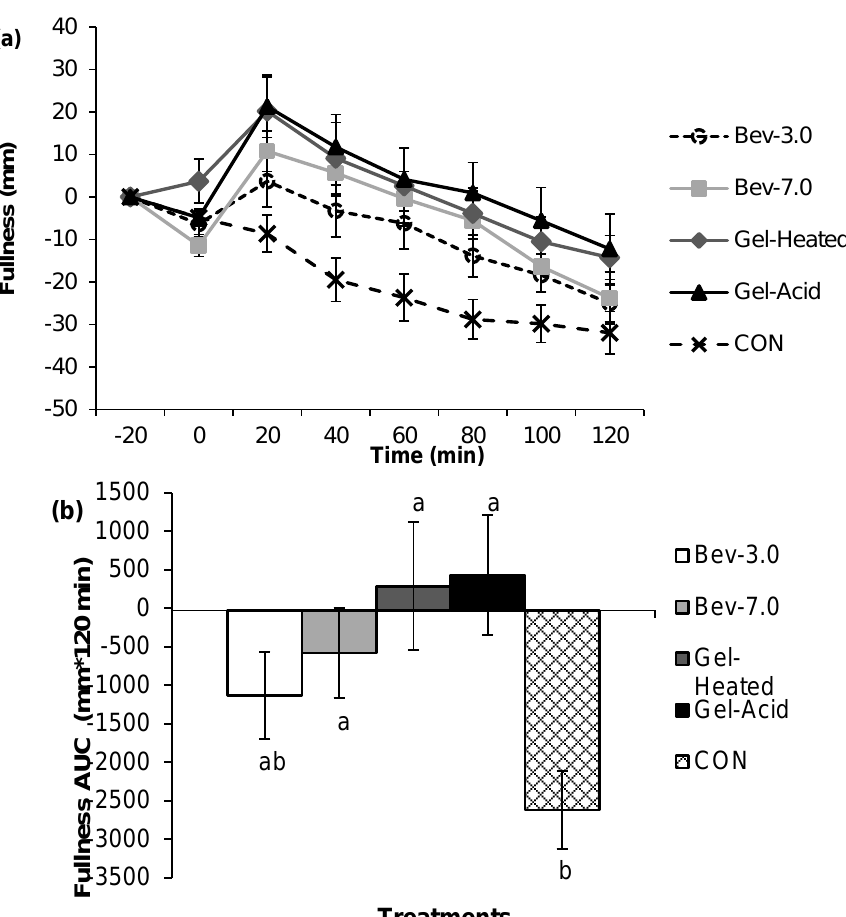
Figure 1. Perceived hunger across time for each treatment ( a , line graph) and the 2-h net incremental area under the curve (AUC) for the different treatments ( b , bar graph). Time 0 is when the snack was consumed. Different letters denote significance ( p < 0.05) between treatments. Snacks: 0 kcal water (CON) or 96 kcal whey protein snacks as beverages with a pH of either 3.0 (Bev-3.0) or 7.0 (Bev-7.0) or gels as acid (Gel-Acid) or heated (Gel-Heated).